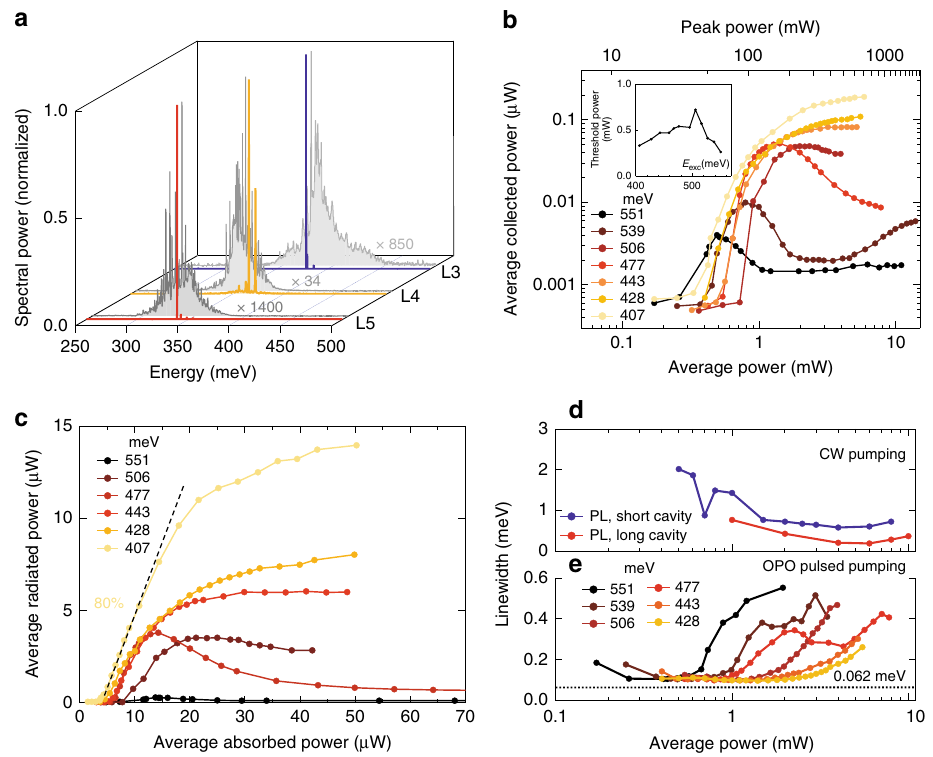
Fig. 2 Strained Ge laser at 20 K. a Normalized spectra taken at 20 K of L3, L4 and L5, whose emission red-shifts with the strain. In grey colours are the photoluminescence (PL) spectra taken at about 4 mW excitation power, excited with a continuous wave (CW) diode laser operating at 590 meV energy. In blue, orange and red the corresponding lasing spectra obtained when the excitation is switched to the pulsed regime, obtained from the tuneable OPO, at an average excitation power of 2 mW, with energy of 551 meV and 428meV, for L4 and L3, L5 samples, respectively. Per each sample, the relative magni fi cation of the PL spectrum with respect to the corresponding laser spectrum is reported. b Average power collected by the objective with a numerical aperture (NA) of 0.4, as a function of the average excitation power (integrated over an area of 100 π /4 µ m 2 ) in pulse regime, for the L5 sample at 20 K. Curves for different excitation energies are shown. Inset: threshold dependency on the excitation energy. c Comparison between the average radiated power and absorbed power, for different excitation energies, for the case of the L5 sample at 20 K obtained by a conversion from b as explained in the main text. The value of the differential ef fi ciency, commonly referred to as slope ef fi ciency, is indicated for the pump energy of 407 meV. d Comparison of the cavity modes linewidth power dependence between two L5 samples, with short and long cavity, under CW excitation. e Linewidth power dependence of the main L5 lasing mode for different excitation energies in pulsed regime. Note that the reported linewidths are apodized and approaching the instrumental resolution of 0.062 meV, as indicated by the dashed